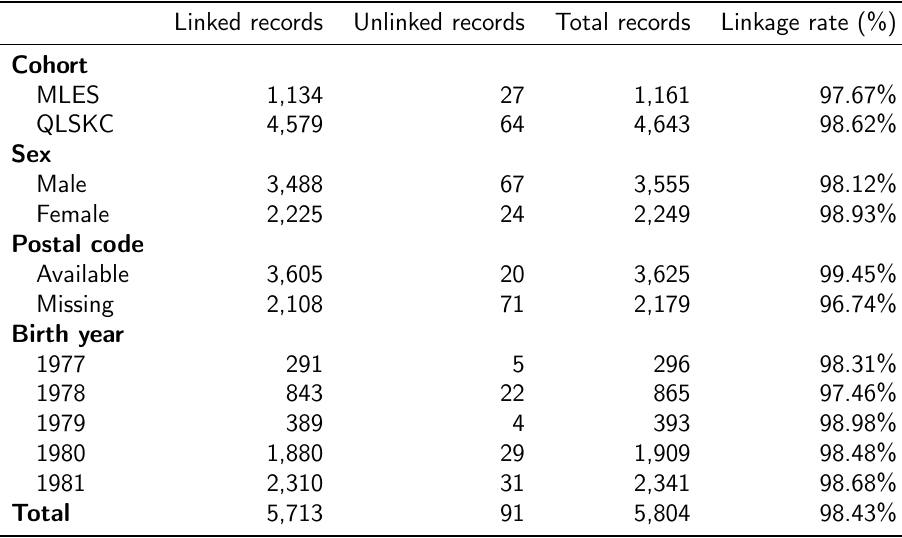
Table 1: Linkage rates for the entire Quebec cohort to the DRD Linked